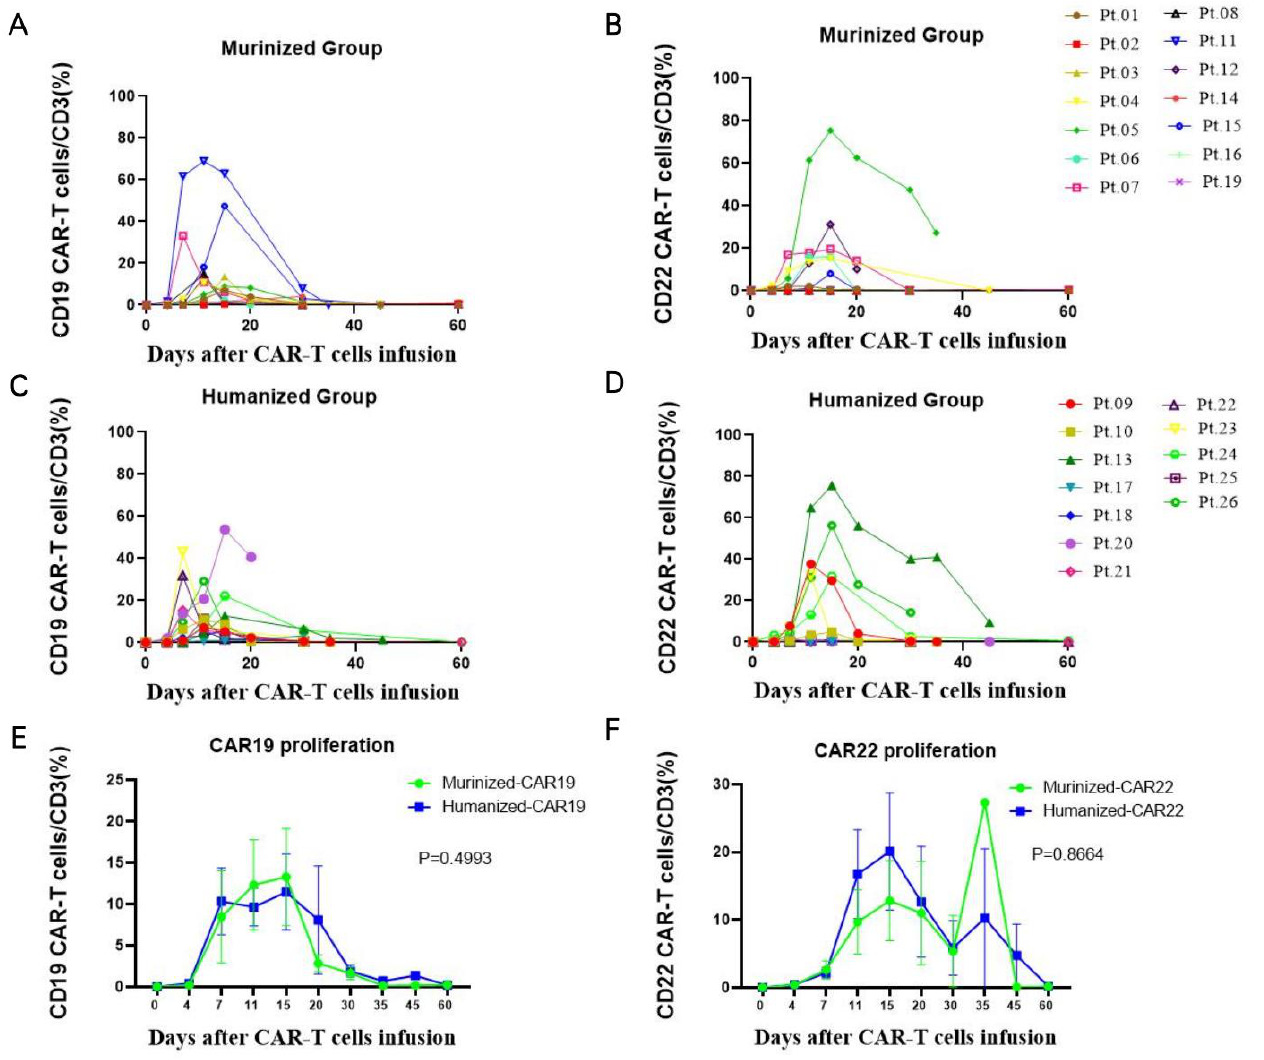
Figure 10. CAR-T cell proliferation in PB measured by FCM. In the murinized group, ( A ) the peak of CD19 CAR-T cells was 9.84% (range: 0.06% – 68.93%) and occurred on day 15 (range: day 7 – day 60), ( B ) and the peak of CD22 CAR-T cells was 1.96% (range: 0.04 – 75.44%) and occurred on day 13 (range: day 4 – day 30). In the humanized group, the peak of CD19 CAR-T cells ( C ) and CD22 CAR-T cells ( D ) was 14% (range: 3.28 – 53.74%) on day 11 (range: day 7 – day 30) and 3.03% (range: 0.09 – 75.7%) on day 15 (range: day 4 – day 20), respectively. There were no significant differences in the CAR19 cell ( E ) and CAR22 cell proliferation ( F ) between the two groups. FCM: flow cytometry; PB: peripheral blood; CAR-T: chimeric antigen receptor-T cell.